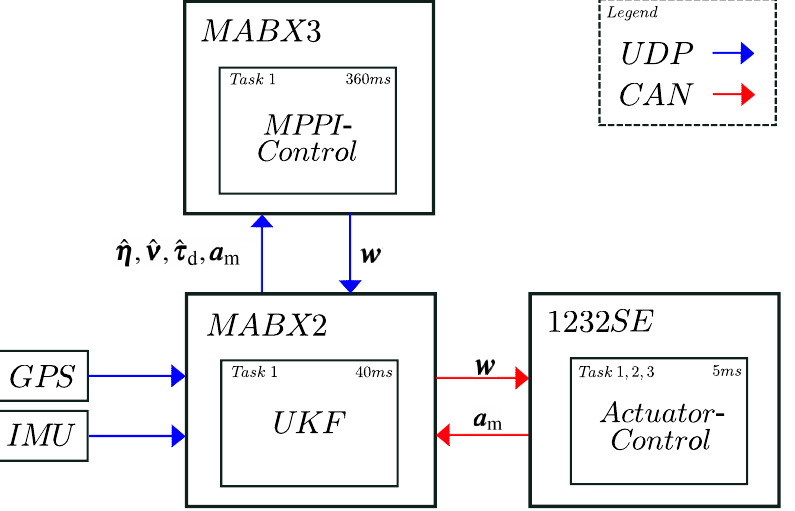
Figure 4. Distributed and modularized control architecture for full-scale experiments on research vessel Solgenia . The connections are realized via UDP and CAN